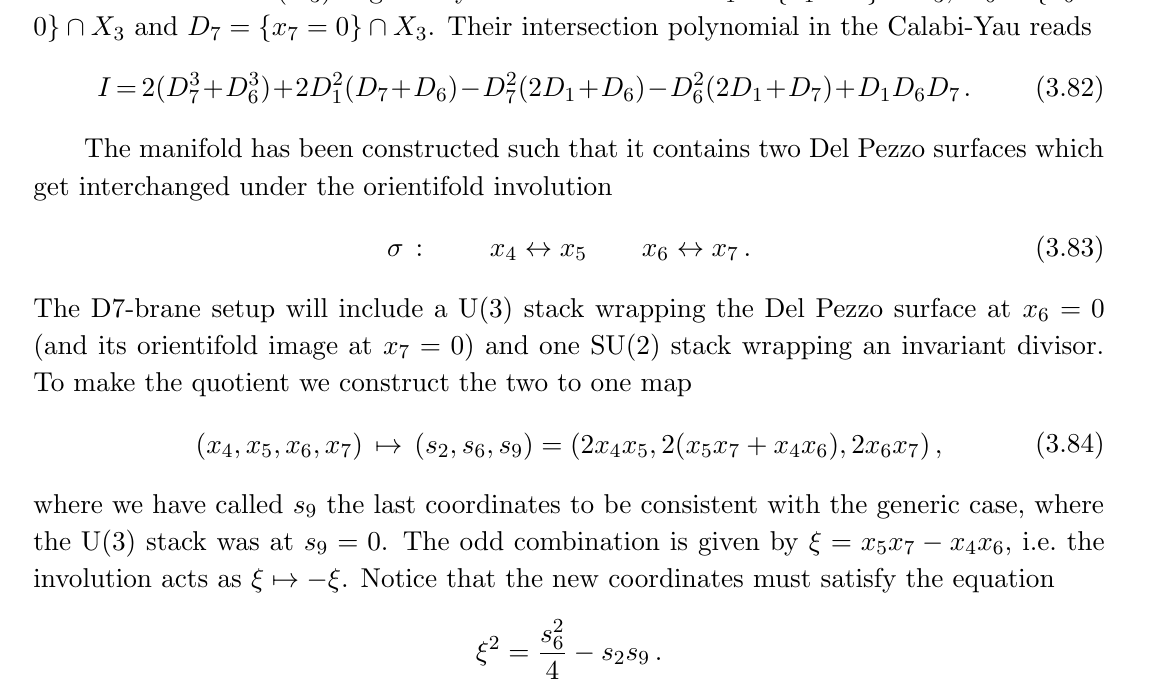
= f x = 0 g \ X , D = f x = 1 1 3 6 6